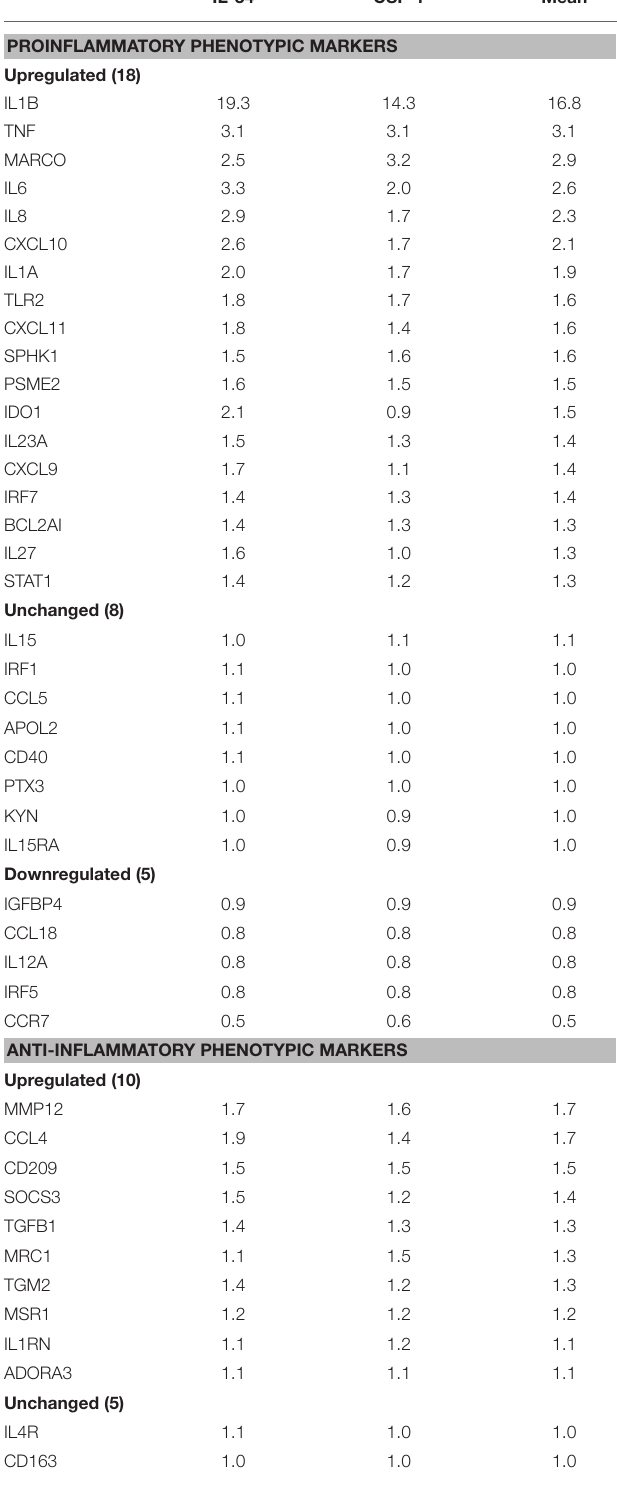
TABLE 4 | Relative Levels of expression of genes designated to correlate with proinflammatory or anti-inflammatory phenotype in microglia groups following treatment with interleukin-34 (IL34) or colony stimulating factor-1 (CSF-1). IL-34